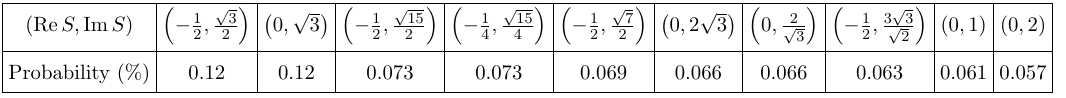
Table 8 . Probabilities of the stable vacua as functions of (Re S; Im S ) in the descending order of the probability for N max = 1000. (cid:13)ux